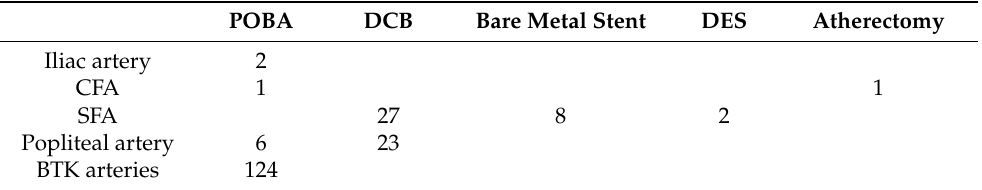
Table 3. Percutaneous transluminal angioplasty procedures according to the treatment segments. POBA DCB Bare Metal Stent DES Atherectomy Iliac artery 2 CFA 1 1 SFA 27 8 2 Popliteal artery 6 23 BTK arteries 124 PTA, percutaneous transluminal angioplasty; POBA, plain old balloon angioplasty; DCB, drug-coated balloon; DES, drug-eluting stent; CFA, common femoral artery; SFA, superficial femoral artery; BTK, below the knee.